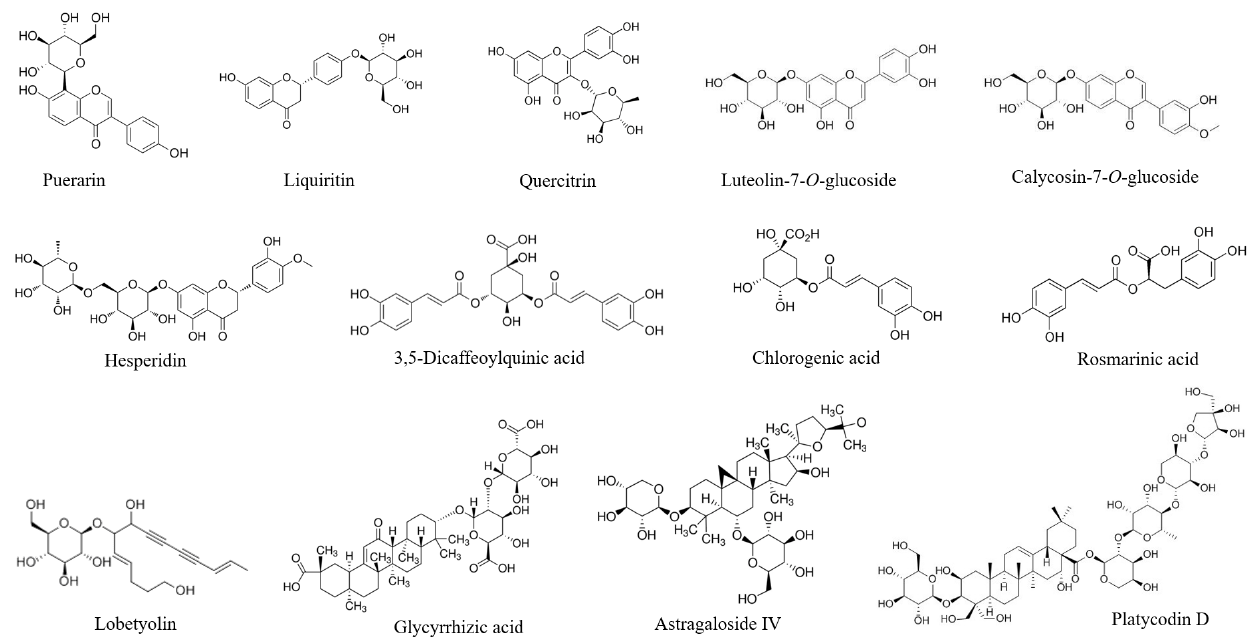
Figure 1. Chemical structure of the active ingredients of the PAFYY.